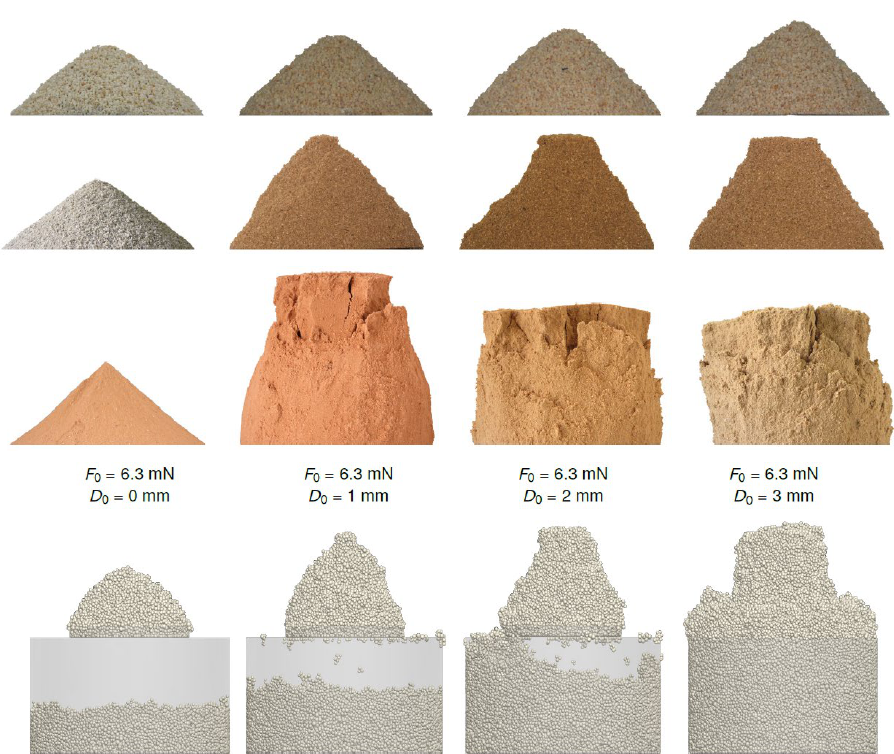
Figure 19. The angle of repose in the vertical displacement setup, from top to bottom: the coarse sand, medium sand, fine sand, and model for the medium sand, and from left to right: dry material, 5%, 10% and 15% saturation. The linear cohesive model was used with the values of the two cohesion parameters, F 0 and D 0 , indicated for each saturation